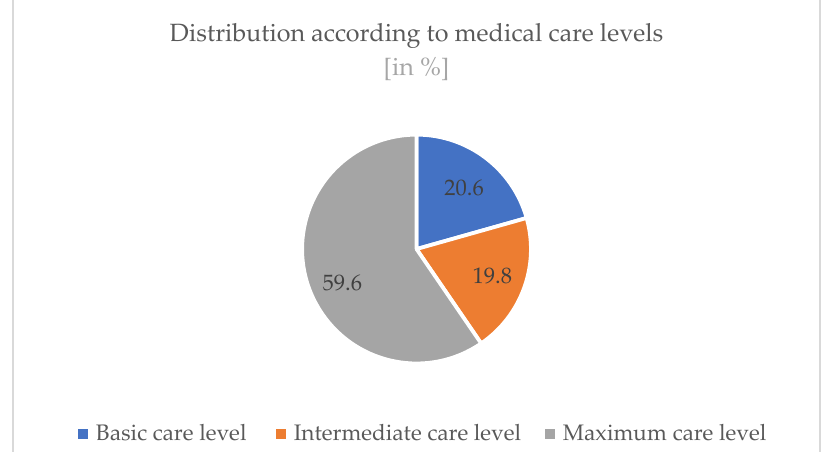
Figure 5. Results of the General Health Questionnaire among participants. 3.2.2. Workloads at the Workplace Overall, the participants (n = 129) rated their total workload with a mean of 2.96 (SD 0.47) (range from 1 to 5 on a Likert- Scale). The subscale “Coordination and Information Problems” had a mean of 2.90 (SD 0.56). The subscale “Psychophysical Overload” was rated with a mean of 3.16 (SD 0.64) (see Figure 6).